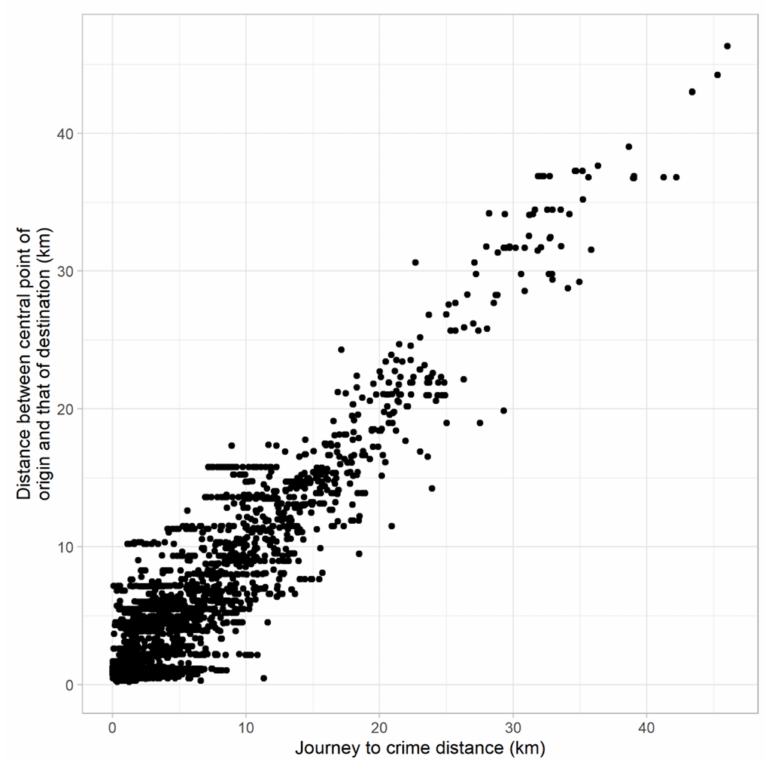
Figure 4. Relationship between journey-to-crime distances and distances connecting central points between origin and destination